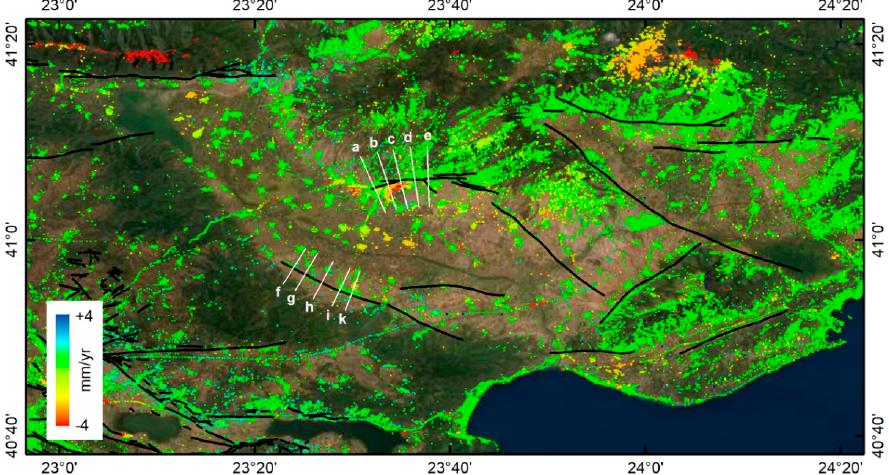
Figure 9. Average LoS displacement rates for the period 2015–2020, derived by SNAPPING service on GEP using Sentinel-1 data from descending track 7. White lines (a–e and f–k) correspond to spatial profiles shown in Figure 8. Please note that, for the selected color scale, rates higher than ± 4 mm/yr appear saturated to allow for the proper visualization of spatial variability of motion.